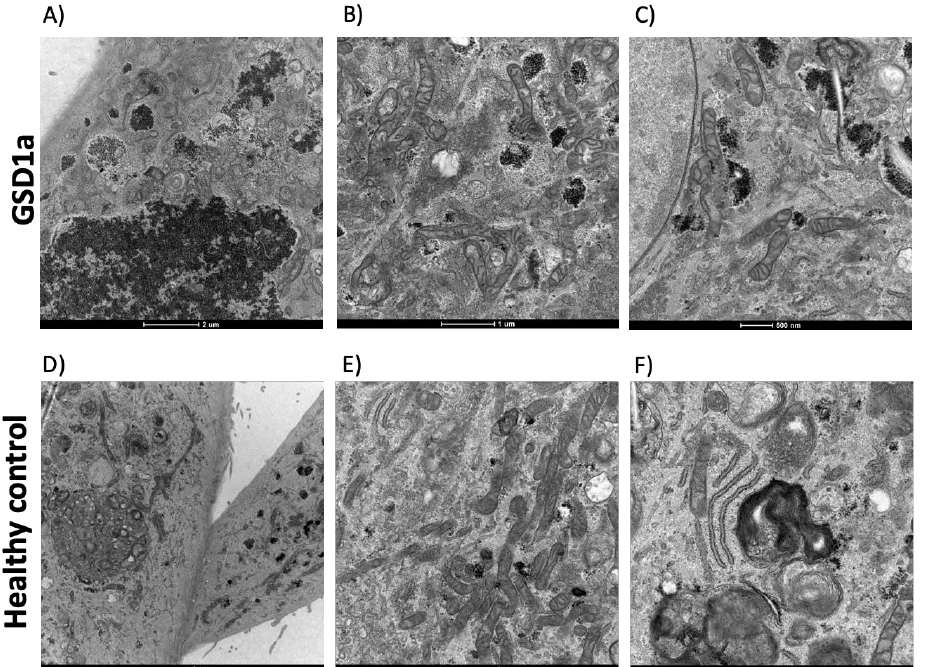
Figure 1. Transmission Electron Microscopy (TEM) was used to provide morphologic information on cells at the fourth passage of culture. Panels ( A – C ): morphology, intracellular glycogen deposits, and organelles of URECs from a GSD1a patient; panels ( D – F ): morphology, organelles, and cilia of URECs from a control subject.